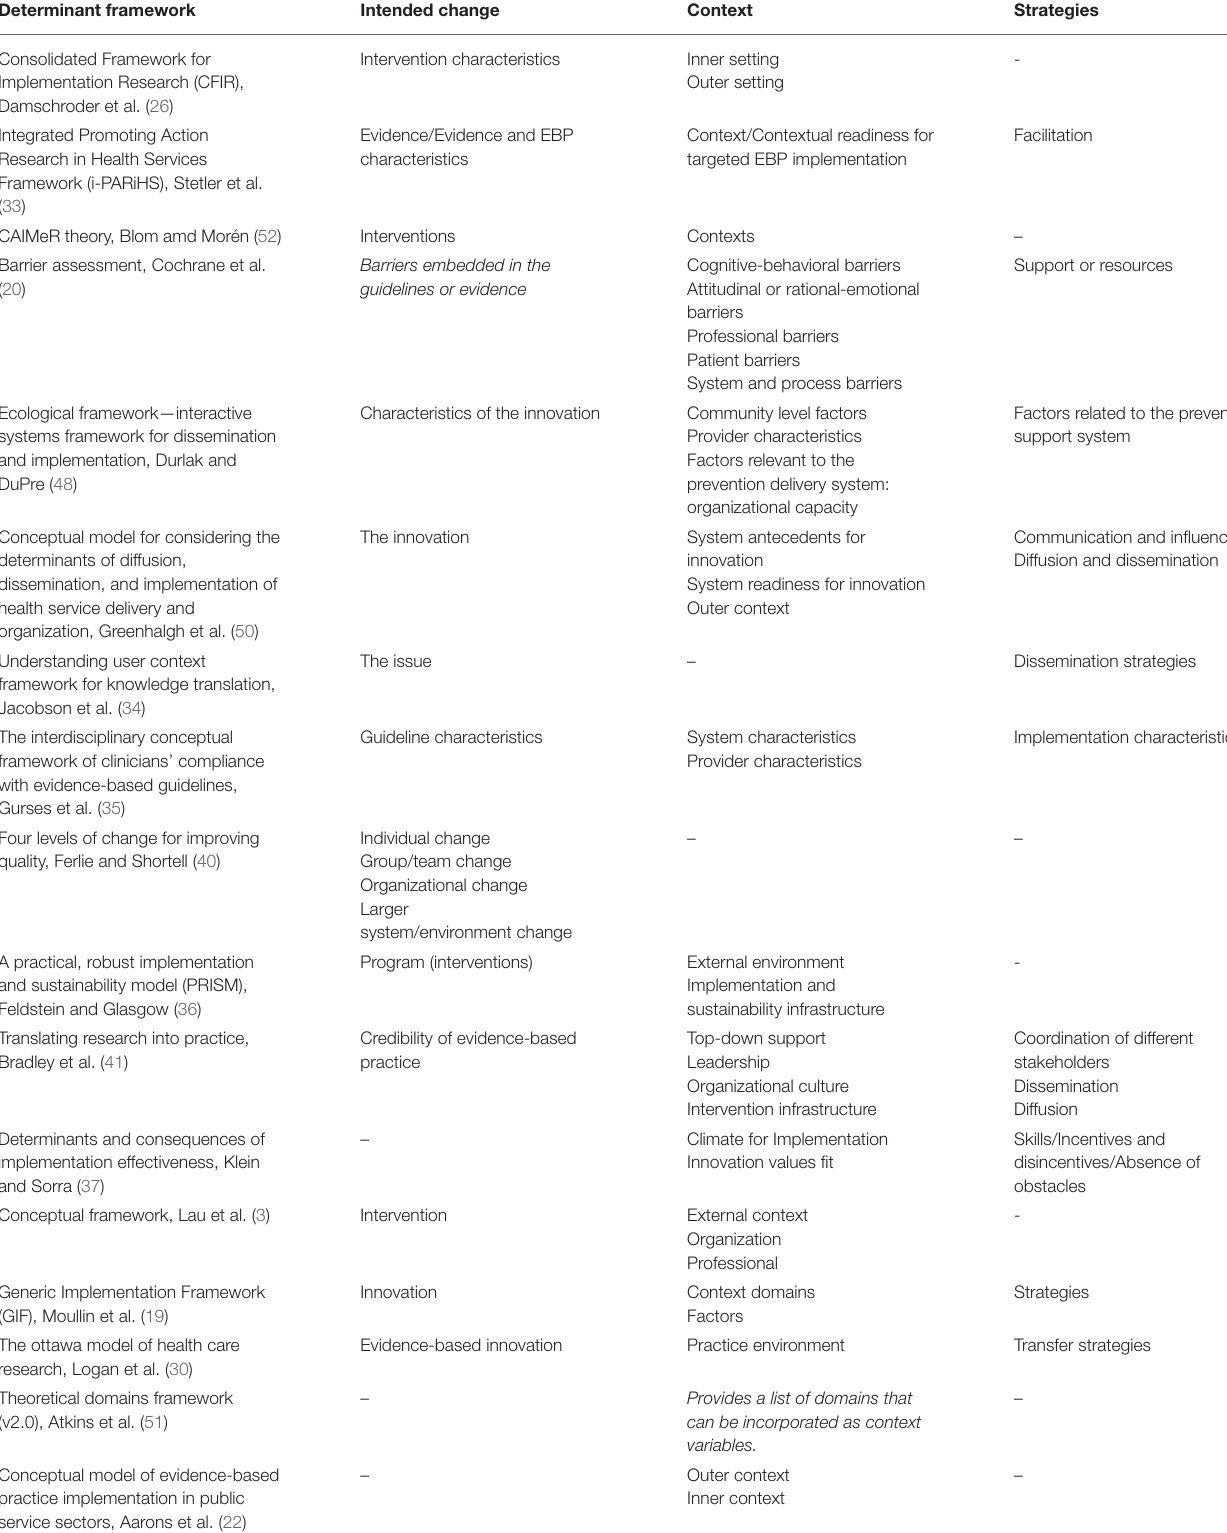
TABLE 7 | Overview of determinant frameworks that incorporate intended change, context, and strategies as